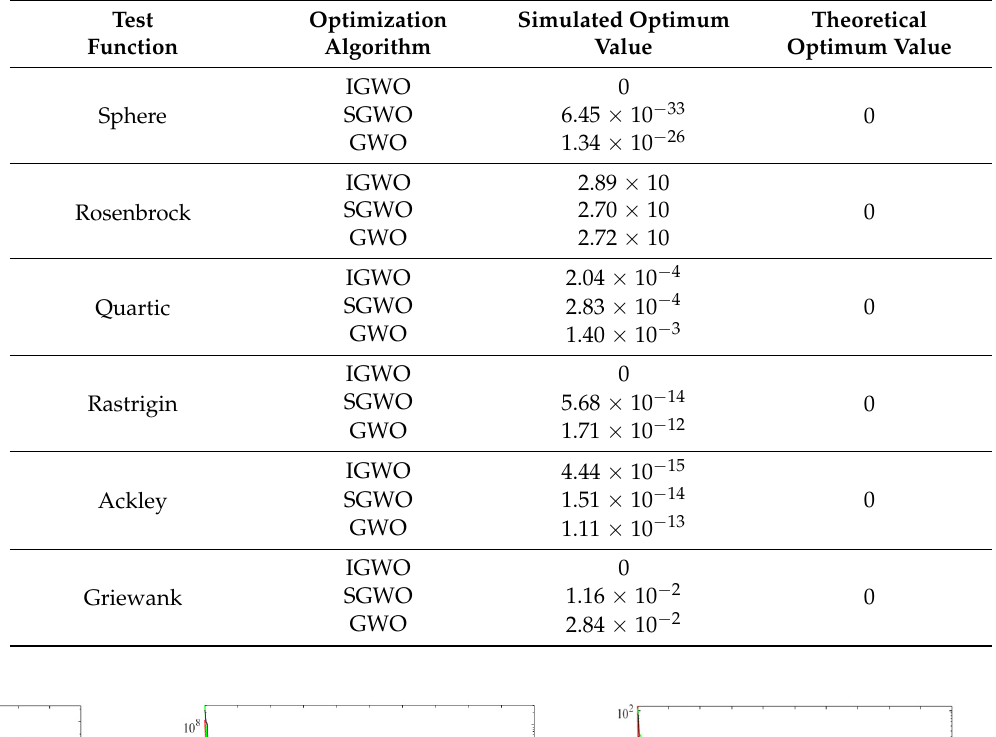
Table 2. Results of the numerical experiments.